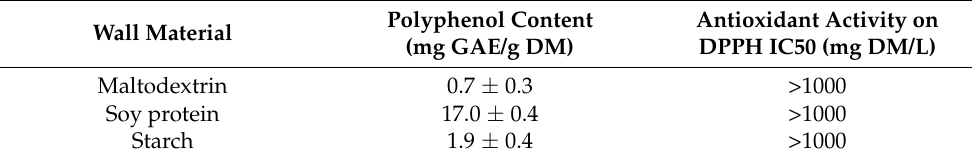
Table 3. Total polyphenol content and antioxidant activity of wall material microparticles.